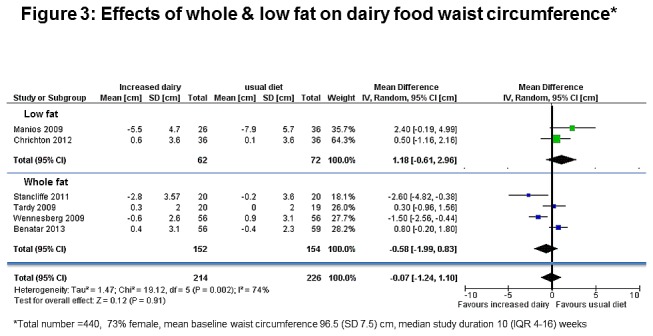
Effects of whole & low fat dairy food on waist circumference.